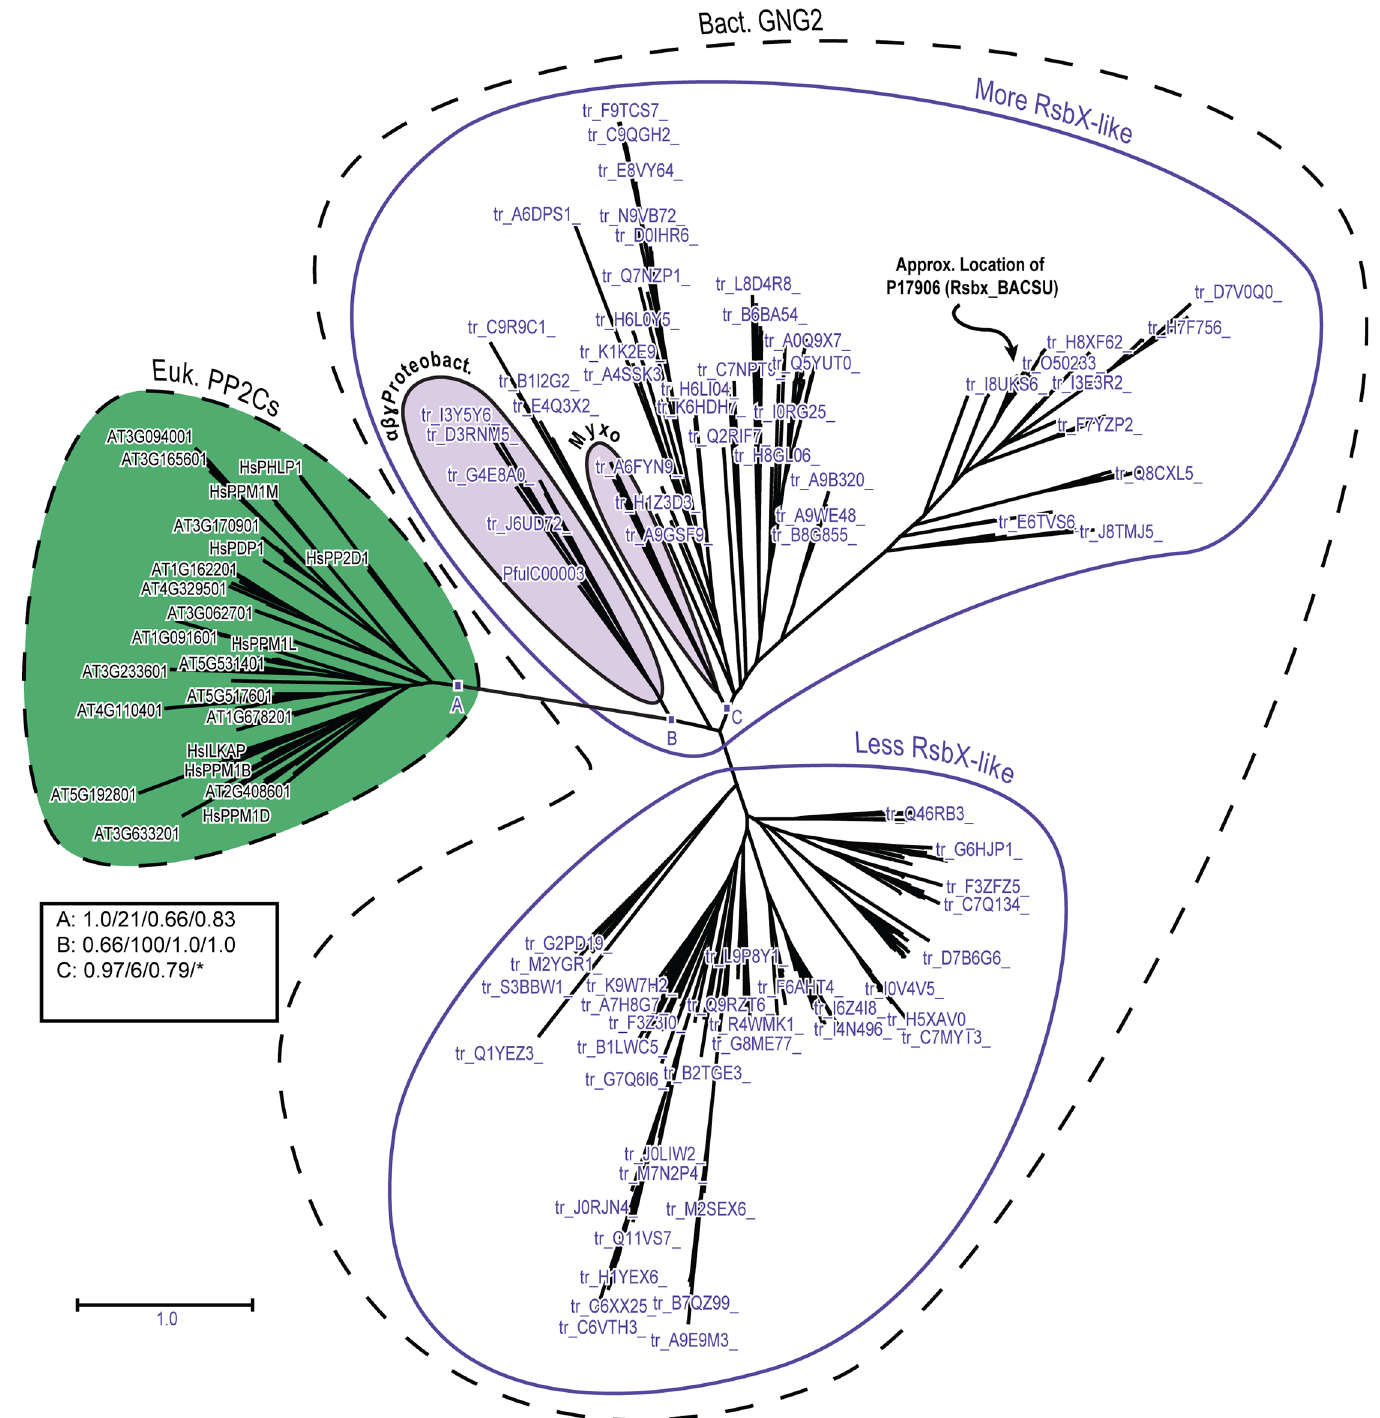
Fig 5. Phylogenetic radial tree depicting interrelationships between eukaryotic PP2C sequences and bacterial Group II PP2C sequences. The eukaryotic PP2C set consists of the combined sequences (excluding PP2C7s) from Arabidopsis and human (96 sequences total — HsTAB1 excluded). The bacterial Group II sequences are of the “ GN ” type, including the “ More RsbX-Like ” and “ Less RsbX-Like ” assemblages (328 sequences total) (see text for explanation of sequence varieties). Inference of unrooted phylogenetic trees was performed as outlined in “ Materials and Methods. ” The most crucial nodes are labeled. Node support values with the four inference methods (PhyML [aBayes], RAxML [RBS], MrBayes [PP], and PhyloBayes_MPI [PP]) are tabulated in the Figure, separated by slashes ( “ / ” ). Support values for all trees are summarized in Table N in S1 File. The cluster of sequences from αβγ -Proteobacteria